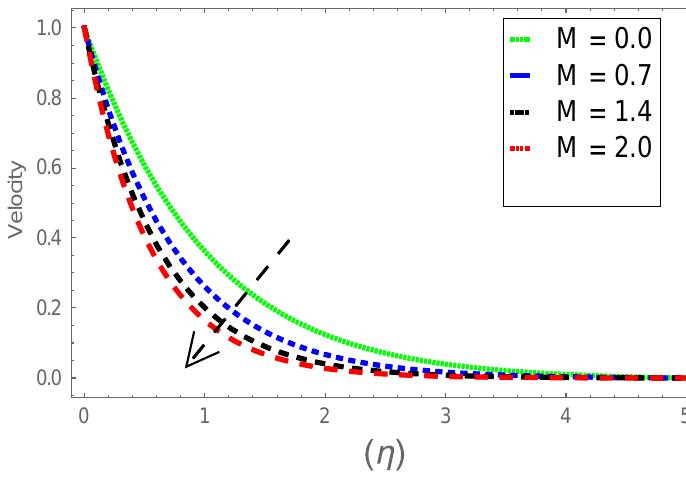
  ' f    ' f  . Figure 12. Consequence of .